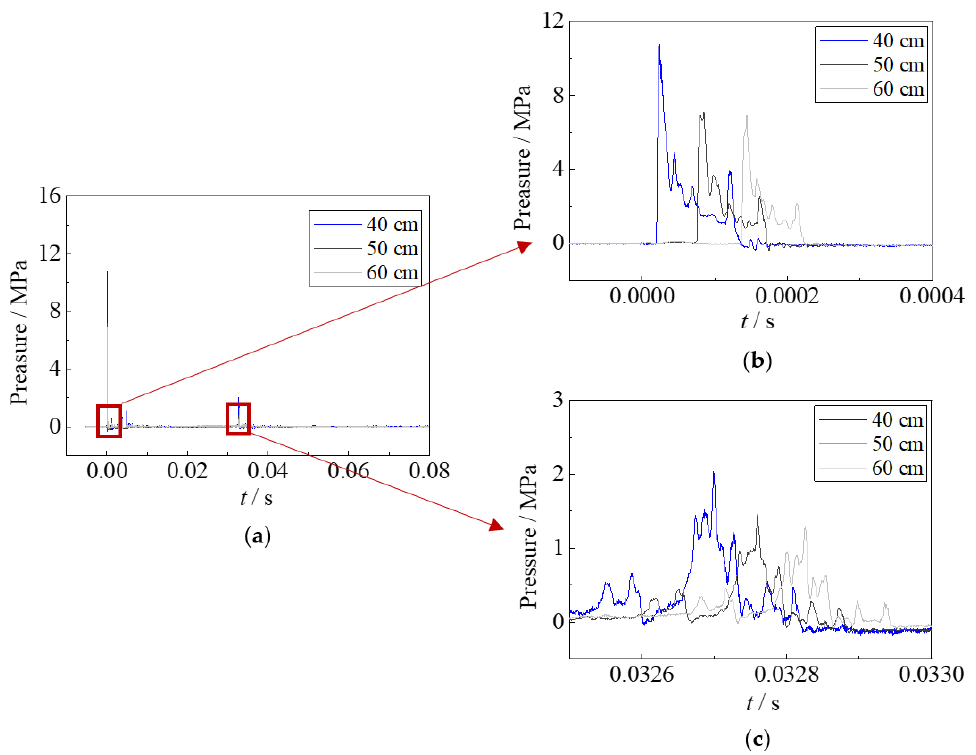
Figure 6. Impulsive pressure of underwater explosion for 2.5 g TNT. ( a ) Whole process. ( b ) Shock wave. ( c ) Bubble pulsation.